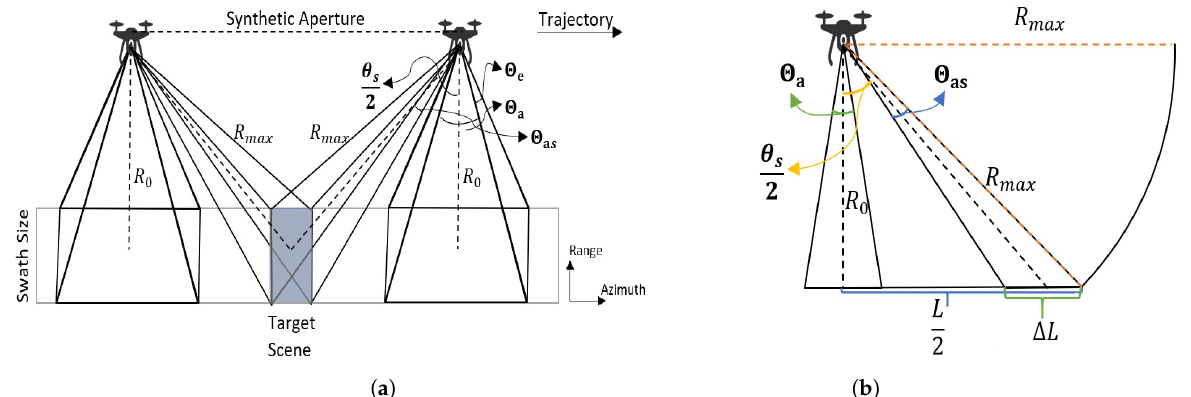
Figure 20. ( a ) The Strip-Spot SAR geometry, including beamwidths and steering angle. ( b ) The cross-section of the Strip-Spot acquisition to determine scene length in azimuth due to